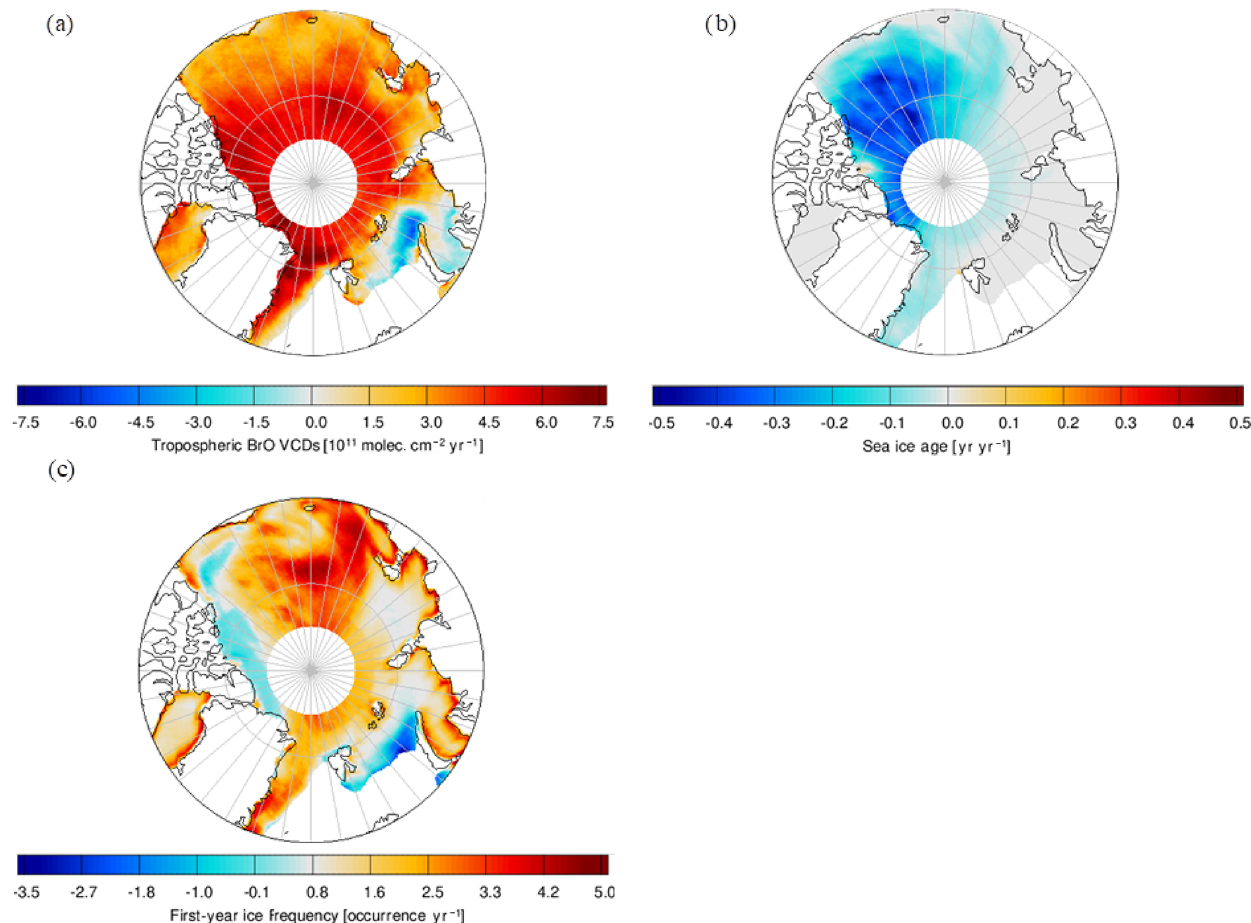
Figure 13. Polar projection of the trend in each grid box (0 . 125 ◦ × 0 . 125 ◦ ) during polar spring months (March, April, May, MAM) for (a) tropospheric BrO VCD over sea ice (10 11 moleccm − 2 yr − 1 ), (b) sea ice age (years per year) and (c) first-year ice frequency (occurrence per year). The trends calculated over a 22-year period (1996 to